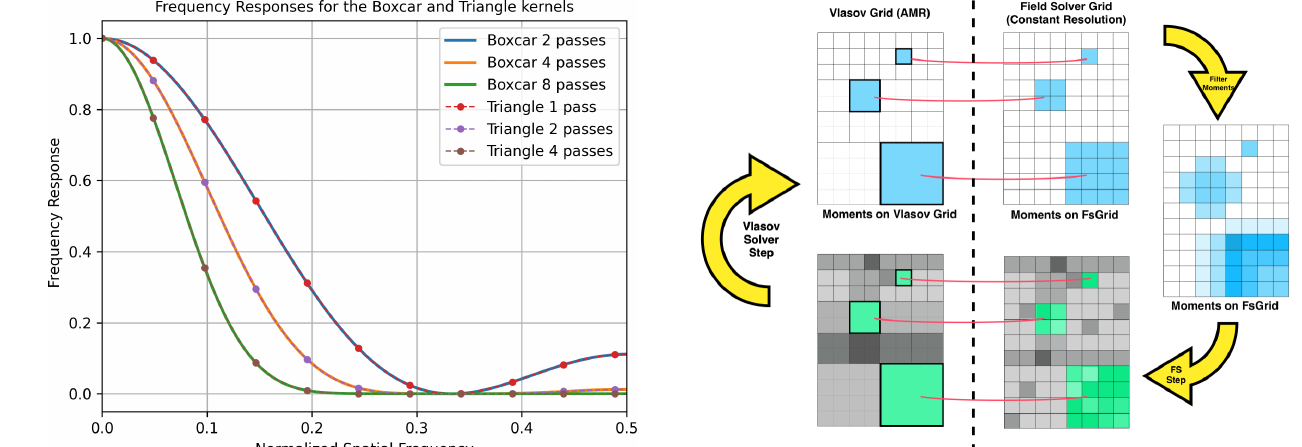
eled space extends from − 560000 to 240000km in the X dimension, from − 368000 to 368000km in both the Y and Z dimensions, and is represented by a 100 × 92 × 92 Carte- sian mesh with (cid:49)r = 8000km at the lowest refinement level and with (cid:49)r = 1000km at the highest refinement level. Each spatial cell contains a velocity space with a 3D grid with (cid:49)v = 40kms − 1 . The solar wind is modeled with proton den- sity n = 7cm − 3 , temperature T = 0 . 5 × 10 6 K and solar wind speed V x = − 1000kms − 1 . The interplanetary magnetic field points mostly southward with B = [− 0 . 5 , 0 , − 20 ]